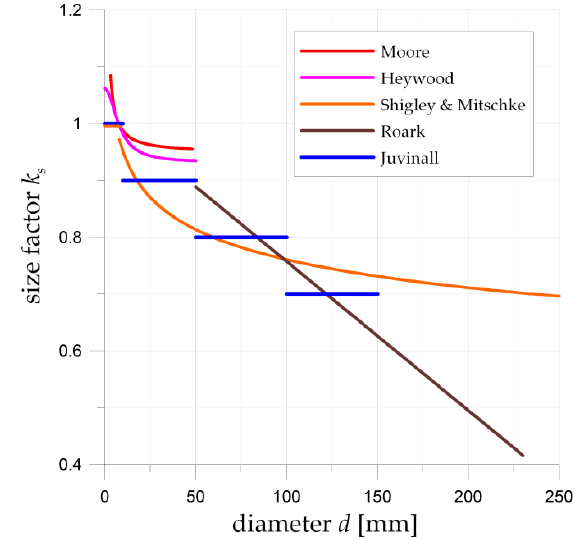
Figure 9. Graphical representation of size factors values k s for various diameters d of the rolling elements for the respective models given in Table 3.